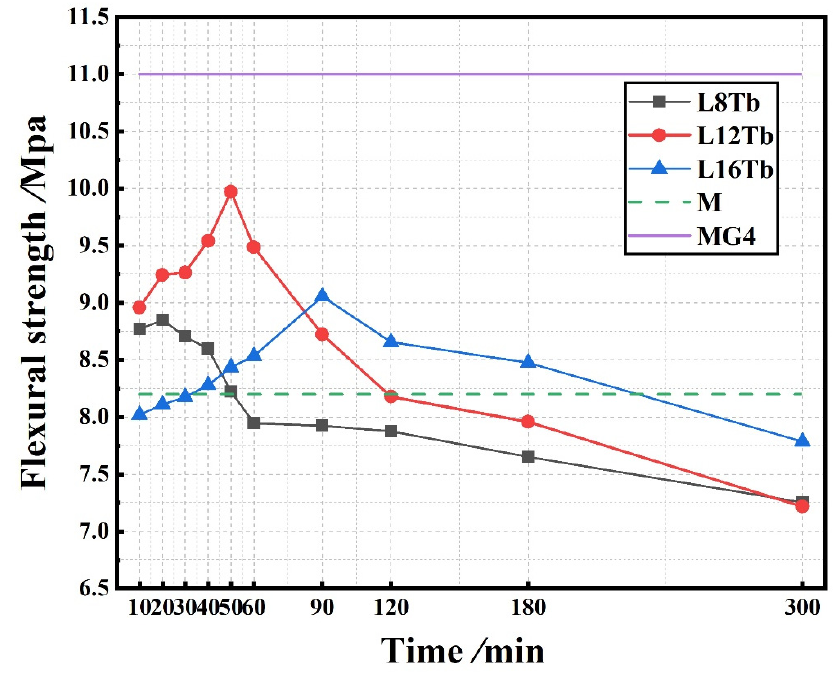
Figure 7. Flexural strength of layered samples.